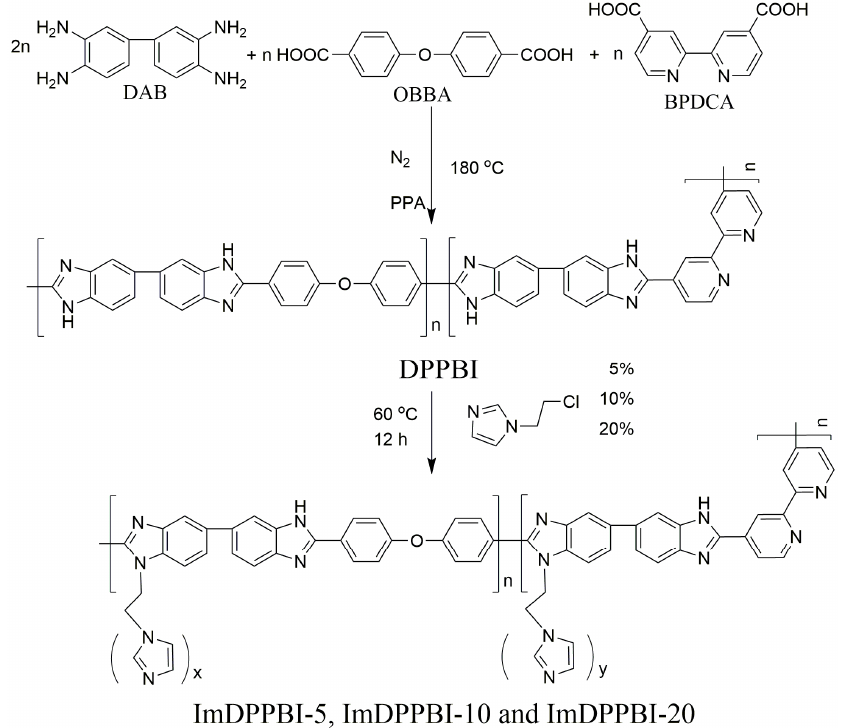
Figure 1. Schematic of PBI synthesis.